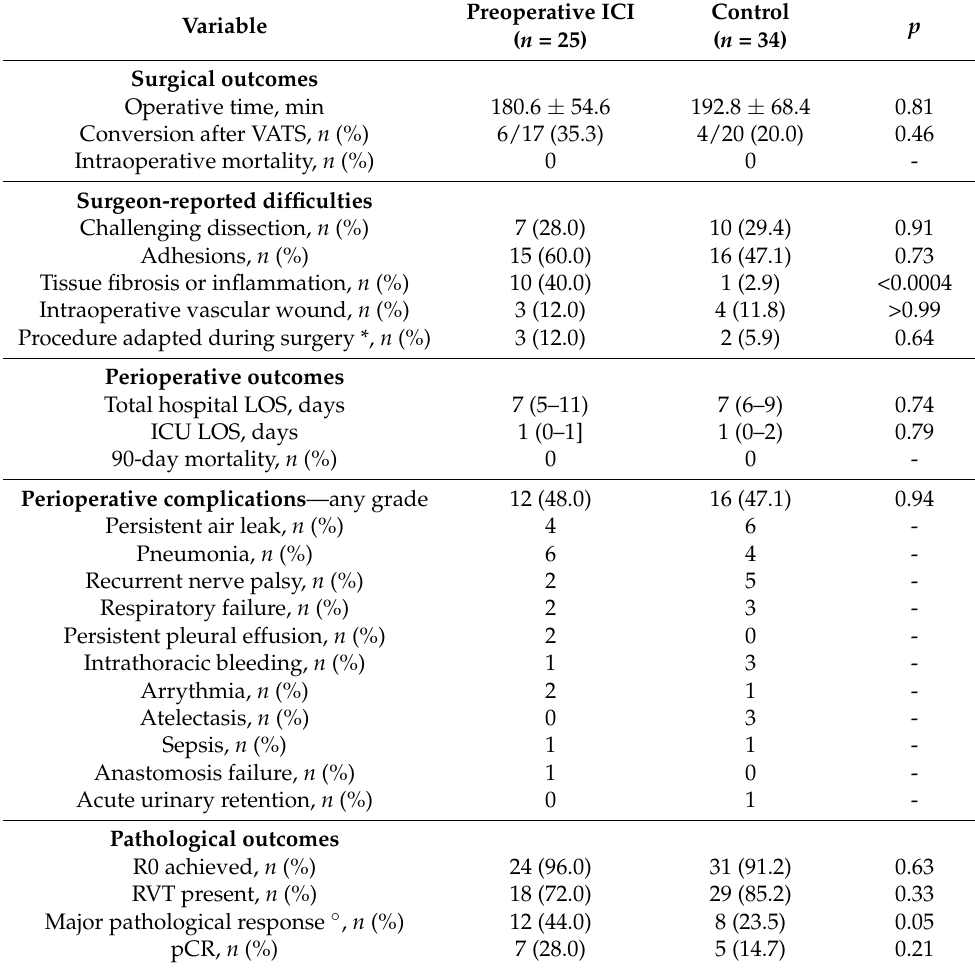
Table 3. Comparison of surgical, perioperative, and pathological